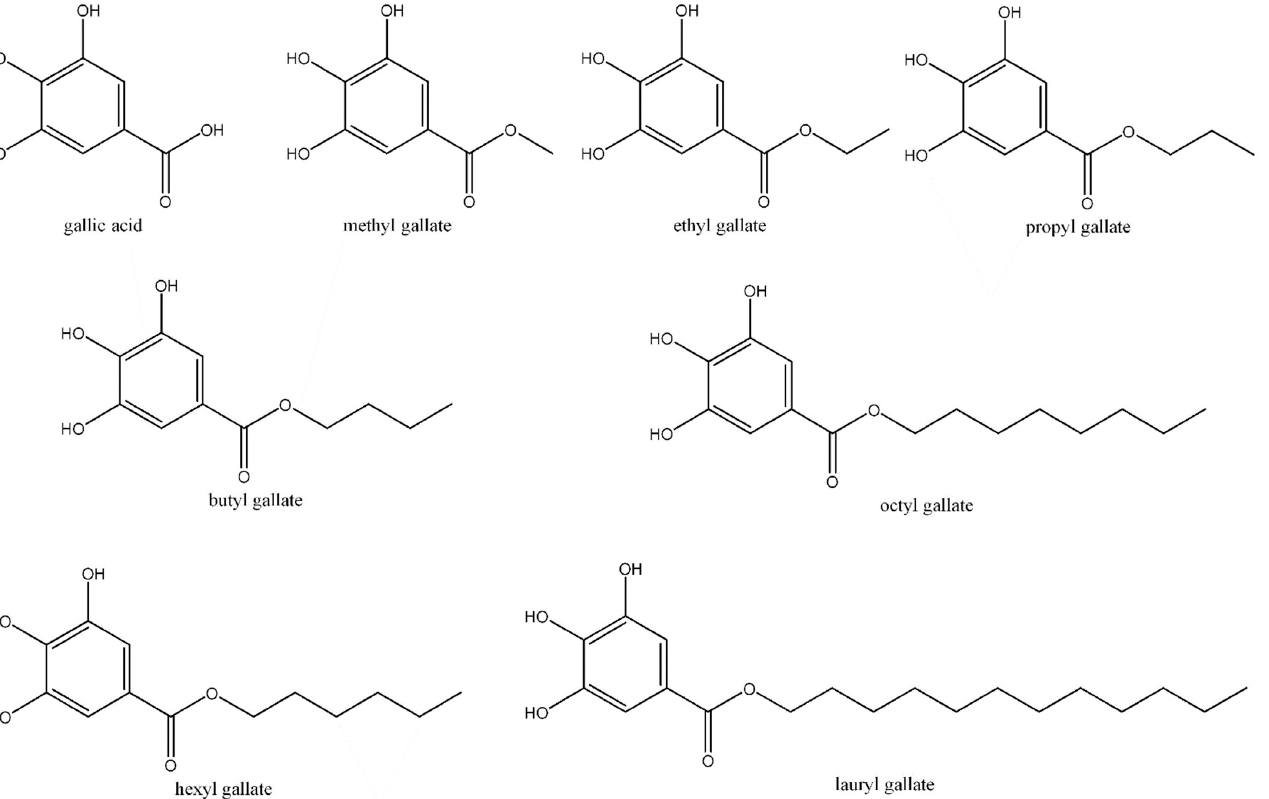
Figure 2. Chemical structure of alkyl gallate derivatives.